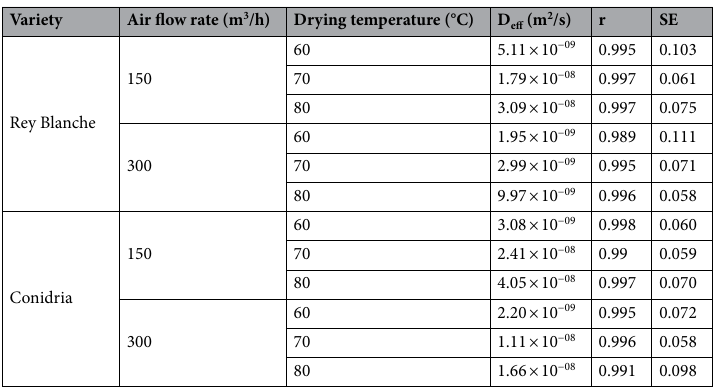
Table 6. Values of effective diffusivity of fig slices.